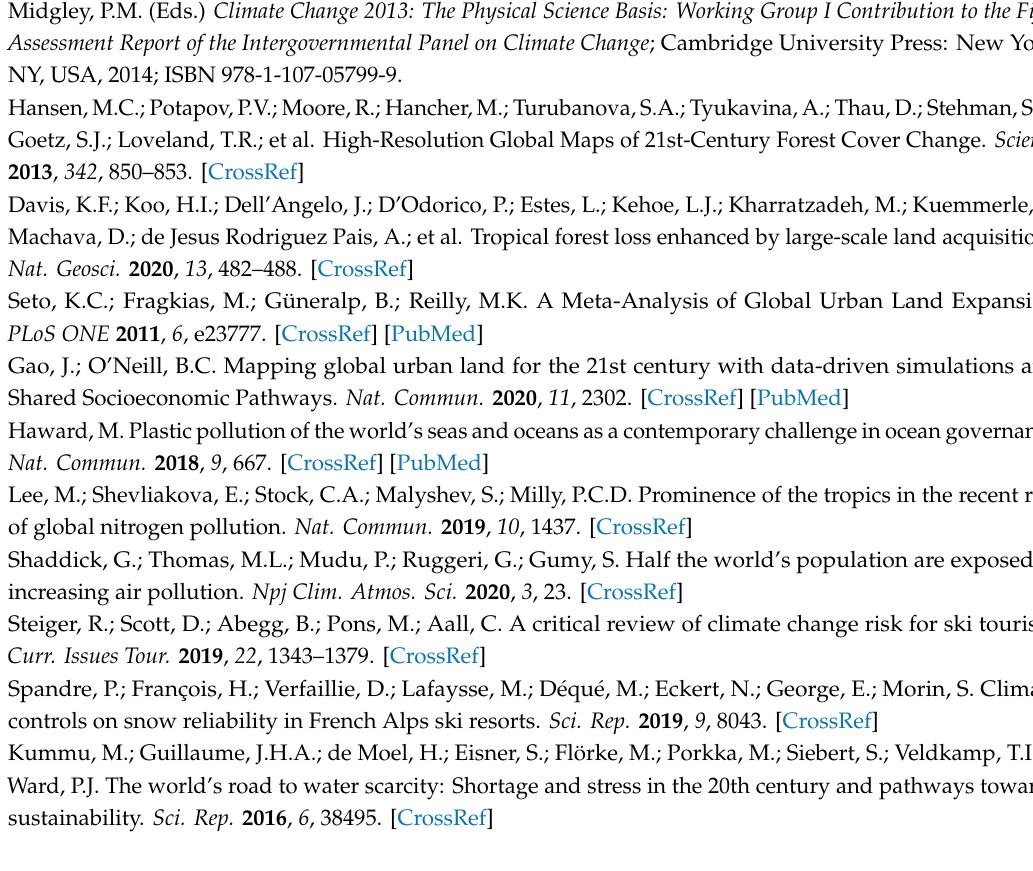
Table S1: List of references and analyzed parameters of the literature